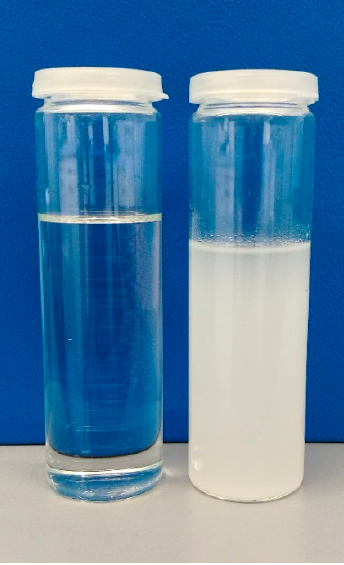
Figure 15. Photograph of artificial emulsion before the filtration ( right ) and filtrate ( left ) using a superhydrophobic filter.